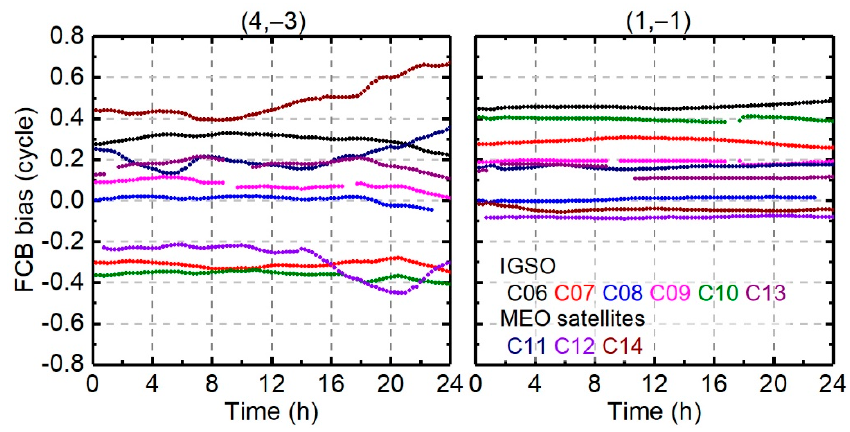
Figure 11. One day (3 September 2019) BDS-2 FCB time series of the NL and WL combinations for the inclined geosynchronous orbit (IGSO) and medium Earth orbit (MEO) satellites.